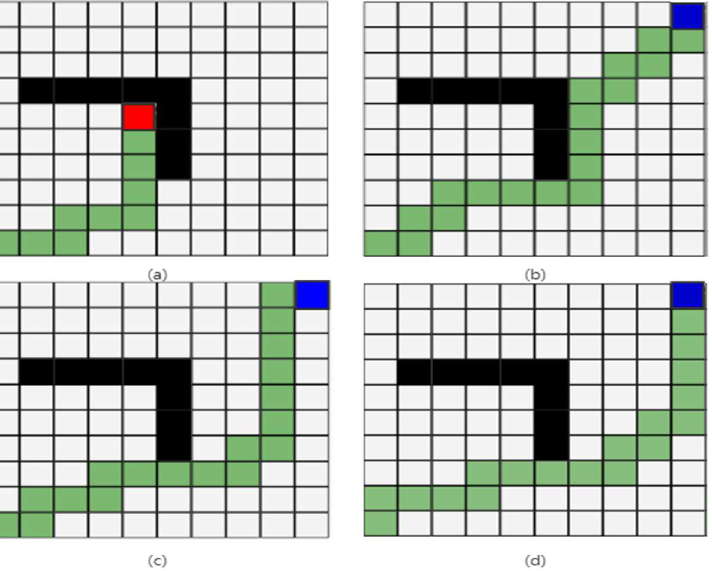
Figure 7. AGV roadmap. The red grid represents not reaching the end point, and the blue grid means reaching the end point successfully. ( a – d ) represent the trajectories at different numbers of iterations, respectively.